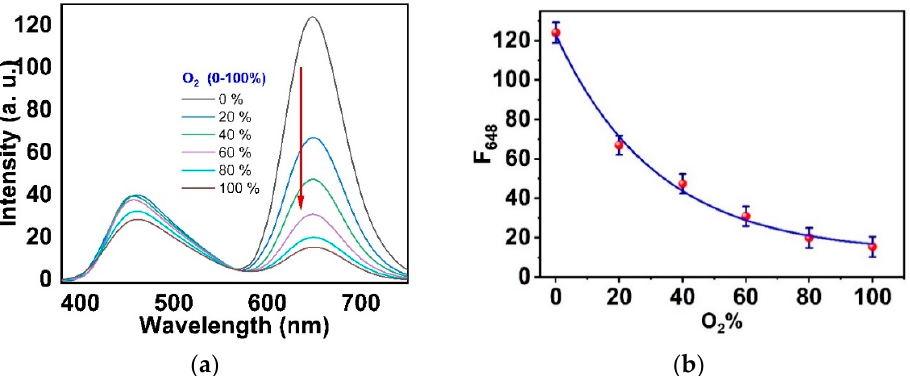
Figure 10. ( a ) The emission of the ormosil nanosensor at different concentrations of O 2 (0–100%); ( b ) the calibration curve of the nanosensor at different oxygen concentrations upon excitation with 365 nm.